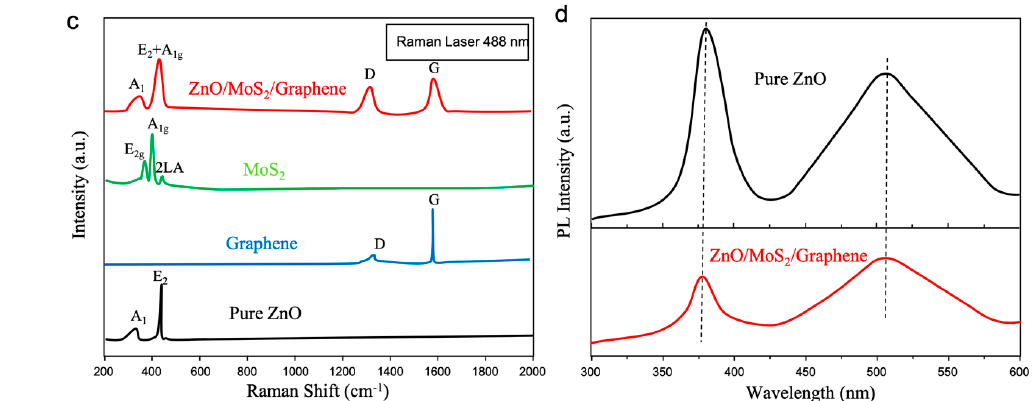
Figure 4. Schematics of heterostructures and electron transfer in photocatalytic processes. ( a ) 3D view of the ZnO / MoS 2 / graphene heterostructures; ( b ) energy diagram and generated electrons transfer during visible-light illumination.